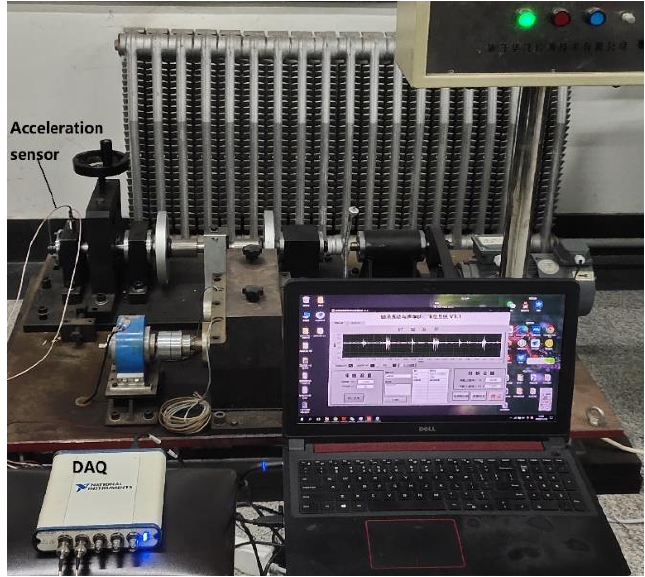
Table 3. Experimental bearing specifications.